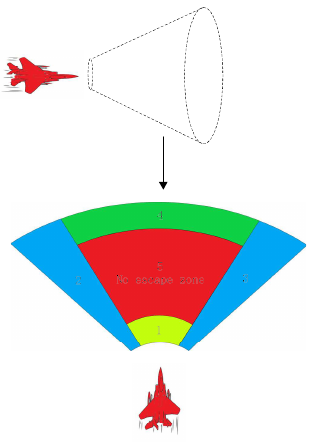
Figure 3. Schematic diagram of the attack area.